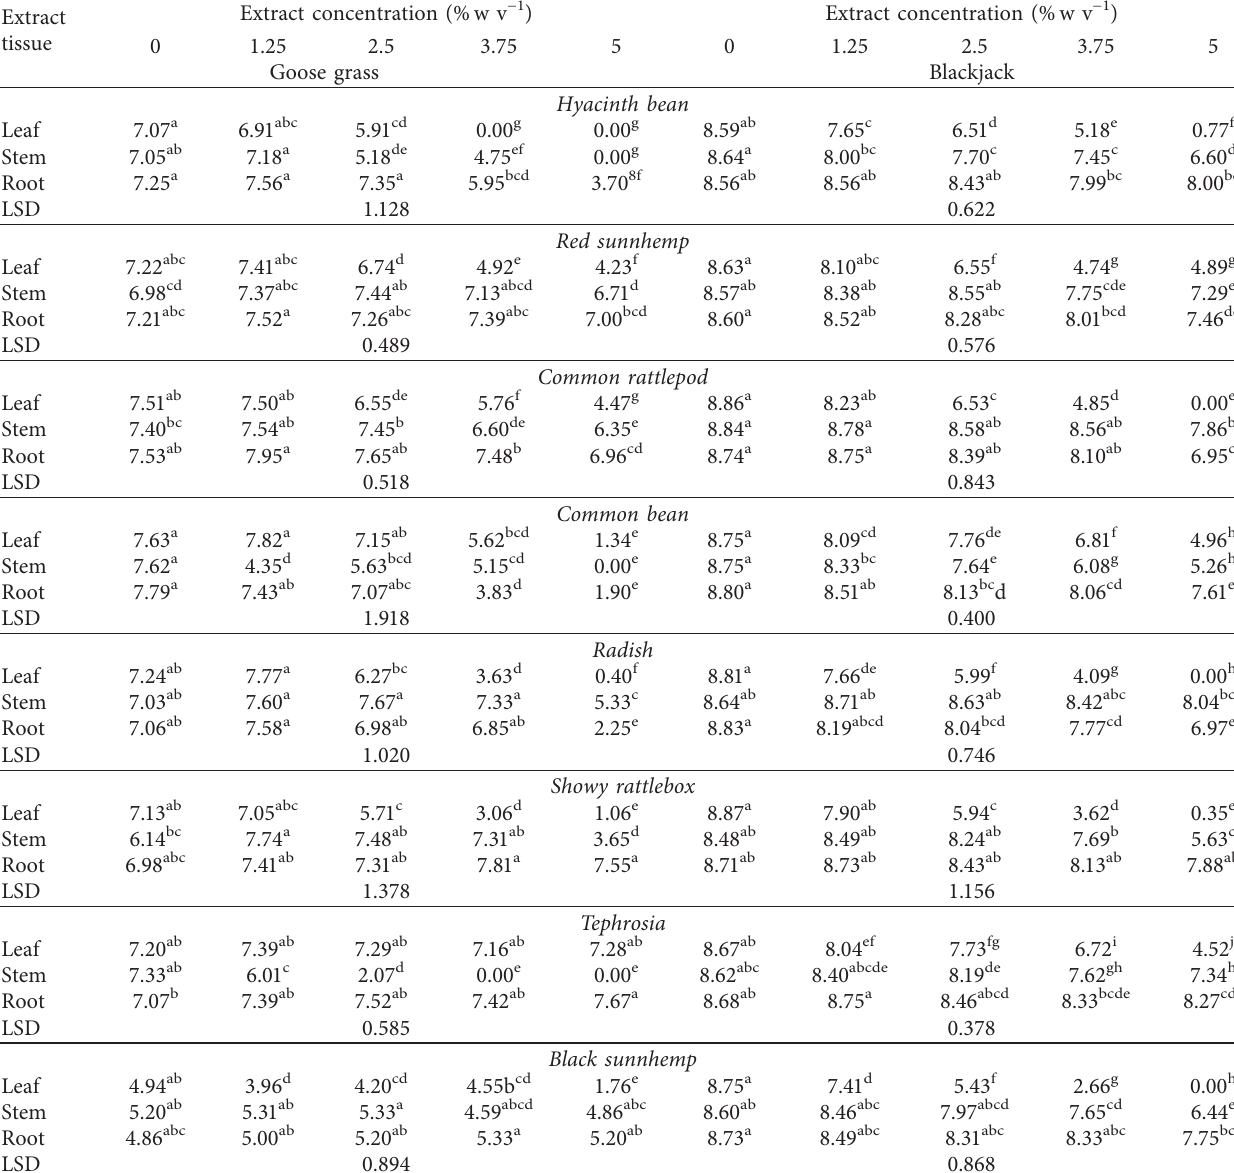
Table 6: Effect of aqueous extracts of eight green manure cover crops on the seedling vigor index (SV1) of goose grass and blackjack.